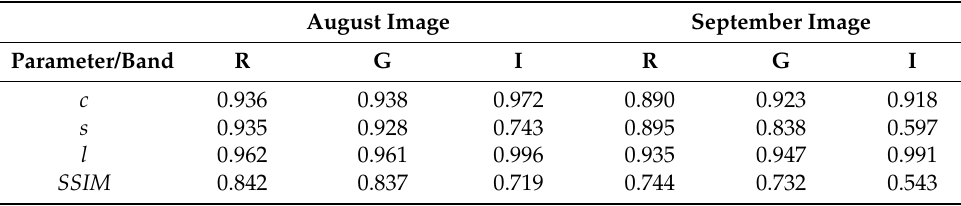
Table 3. The similarity between original drone images. Reference: July